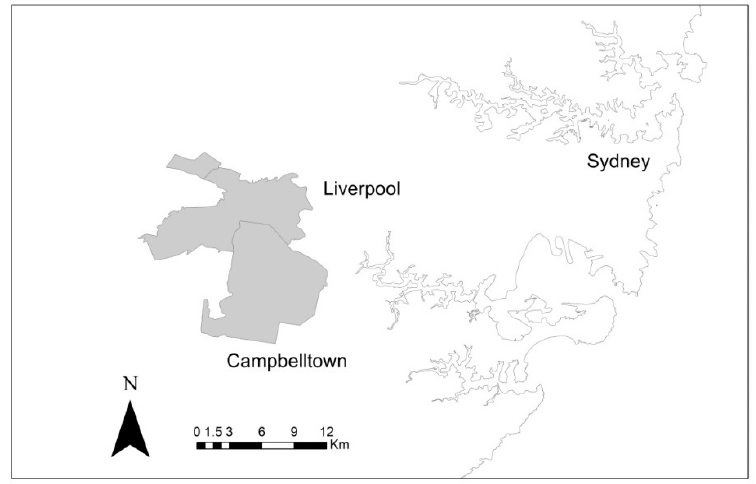
Figure 5. Scanning windows were used to investigate the possibility of clusters of FeLV exposure/infection in Group 1. Based on a scanning window of up to 10% of the population at risk, a cluster of abortive infections (i.e., FeLV-exposed cats) was identified in western Sydney, New South Wales (postcodes 2170, 2173, and 2177; grey shading).